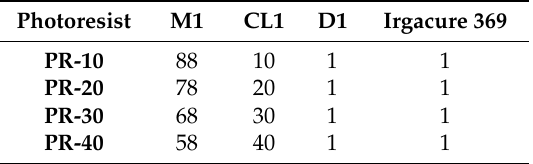
Table 1. Photoresists composition (mol % of the total